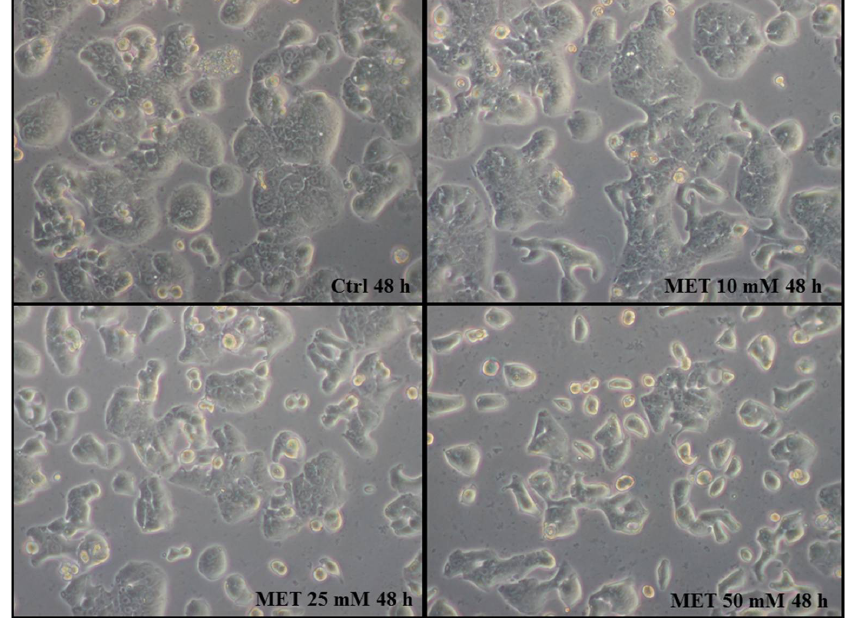
Figure 1. Inverted microscope image of HT29 cells treated with graded concentrations of metformin, 10 mM/25 mM/50 mM for 24 h and 48 h; and of untreated cells (CTRL). The phenotype of HT29 cells treated with metformin was preserved, although cell adhesion to the culture plates caused some changes in the characteristic rounded shape of untreated HT29 cells. Magnification 40×.